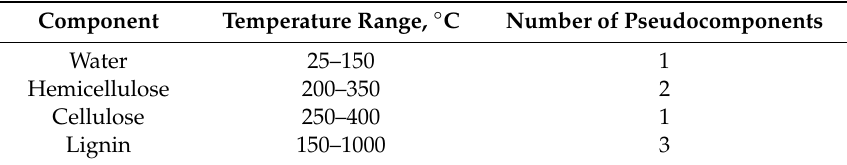
Table 3. Minimum number of components for each biomass